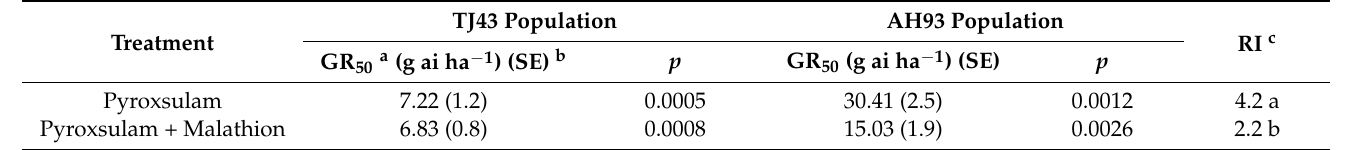
Figure 1. Dose–response curves after pyroxsulam treatment with or without malathion in the resistant (AH93) and susceptible (TJ43) black grass populations. Fresh weights were measured after 21 days of treatment and are represented as a percentage of the untreated control value. Table 1. GR 50 values of pyroxsulam for the susceptible TJ43 and resistant AH93 A. myosuroides